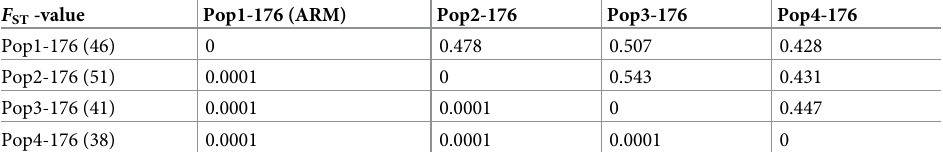
Data are based on the analysis of 23 Armenian strains combined in the data set of 176 strains of L . infantum and the populations inferred by STRUCTURE. F ST values are in the upper triangle, p -values in the lower triangle. Number of strains is given in